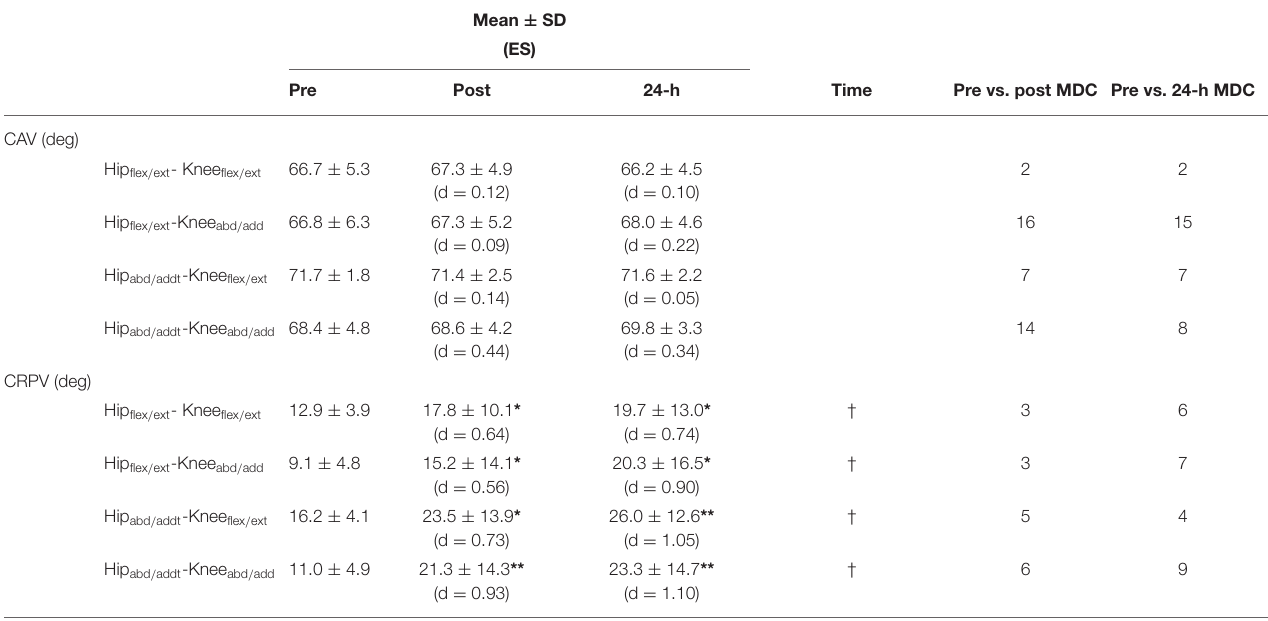
TABLE 5 | Joint coupling interactions of sagittal and frontal plane movements of the hip and knee measured through vector coding coupling angle variability (CAV) and continuous relative phase variability (CRPV) during SPR runs at pre, post, and 24-h post training run represented as mean Cohen’s d ) and minimum detectable change (MDC) for each variable at post and 24-h post compared to